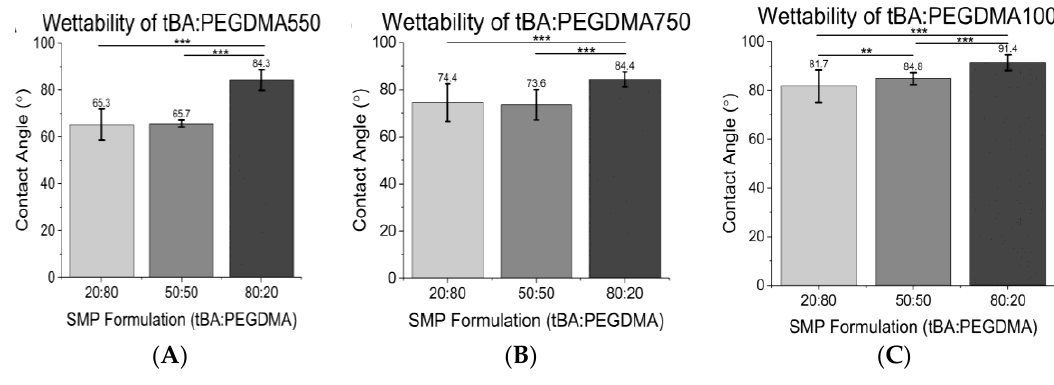
Figure 3. ( A ) Wettability of tBA:PEGDMA550; ( B ) Wettability of tBA:PEGDMA750; ( C ) Wettability of